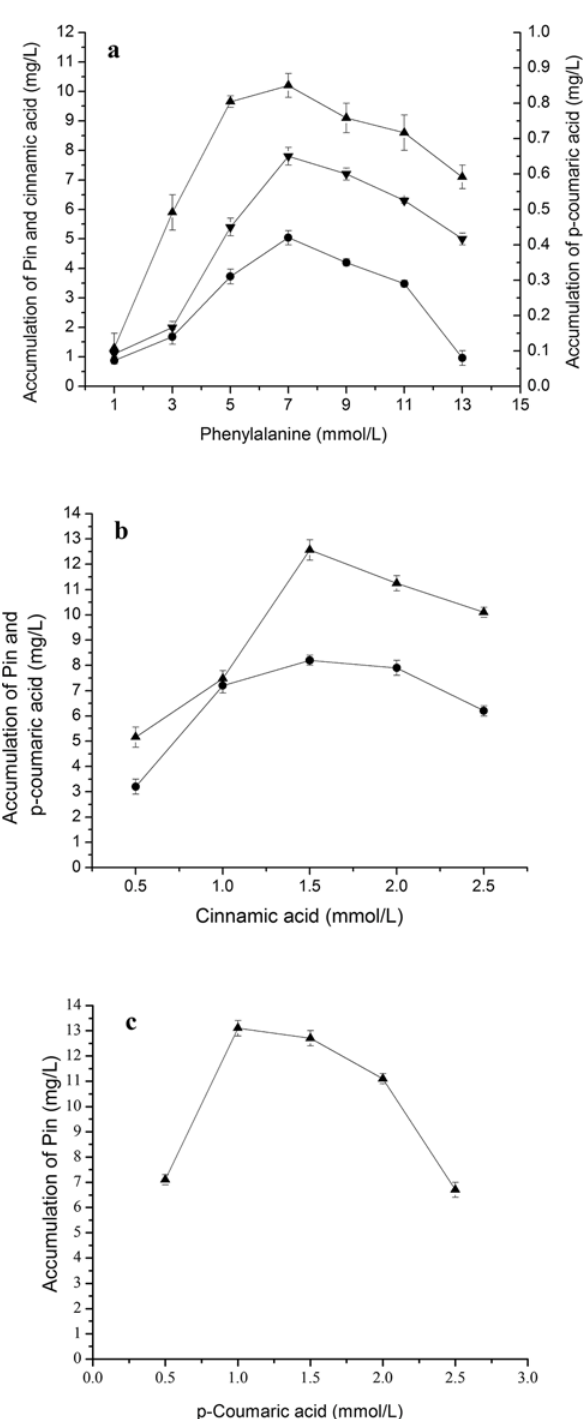
Fig 5. Bioconversion of Pin from Phe, cinnamic acid and p- coumaric acid. The reaction time was 40 h for phenylalanine in (a), 32 h forcinnamic acid in (b) and 24 h for p -coumaric acid in (c). The signals in the figures indicate cinnamic acid (downtriangle), p -coumaric acid (circle), Pin (uptriangle).